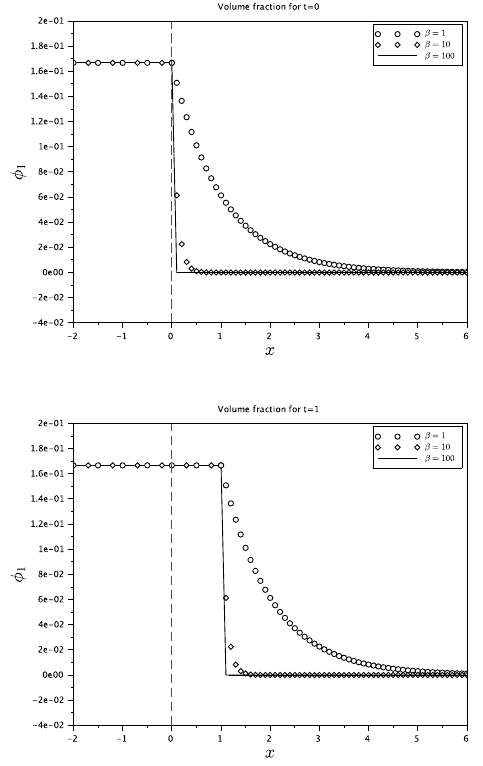
Fig. 4. For network ( φ 1 ) profiles for t = 0 (top) and t = 1000 (bottom). As β increases, the exact solution becomes more accurate at capturing the expected behavior at the sharp interface.